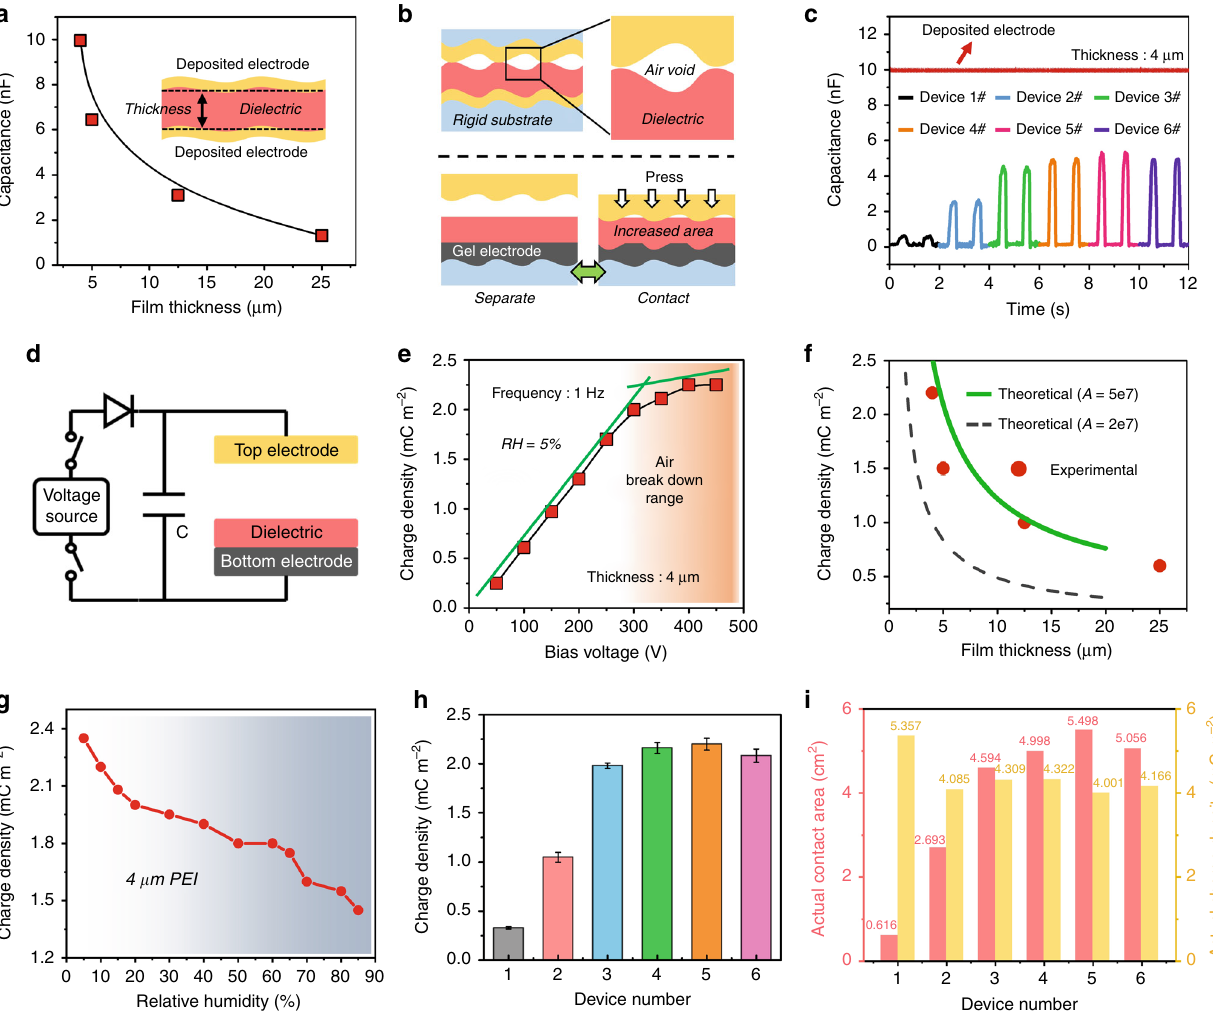
Fig. 2 Critical factors that effect on the real output charge density. a Capacitance of the capacitor made of dielectrics with different thickness (by depositing electrode, electrode area: 3.2 × 3.2 cm). b The schematic of contact status when using a rigid electrode (up) and soft gel electrode (down). c The capacitance of main TENG devices with six contact optimization compared to the one with deposited electrode (regarded as fully suf fi cient contact; dielectric thickness: 4 μ m). d Electric scheme of CE-TENG when exciting by a voltage source. e Output charge density when applying different bias voltage (operation frequency: 1 Hz, relative humidity: 5%, dielectric thickness: 4 μ m). f Experimental and theoretical charge density of CE-TENG with different dielectric thickness. g Output charge density of CE-TENG when varying atmospheric humidity (dielectric thickness: 4 μ m PEI, bias voltage: 400 V). h Output charge density of CE-TENG with different contact status (dielectric thickness: 4 μ m, bias voltage: 350 V). i The actual contact area and